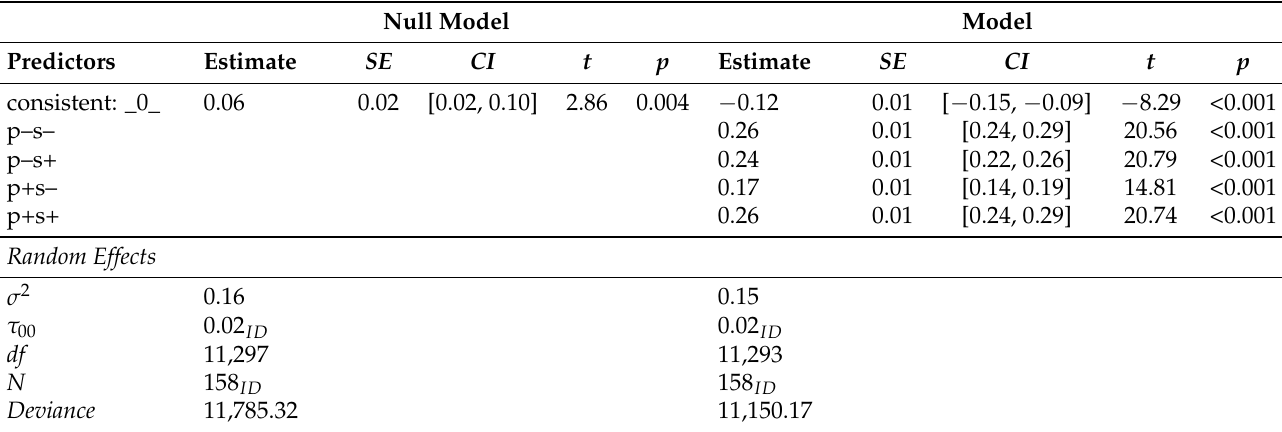
Table A9. Mixed model of the influence of specific stimuli conditions on the emospace arousal vector response.